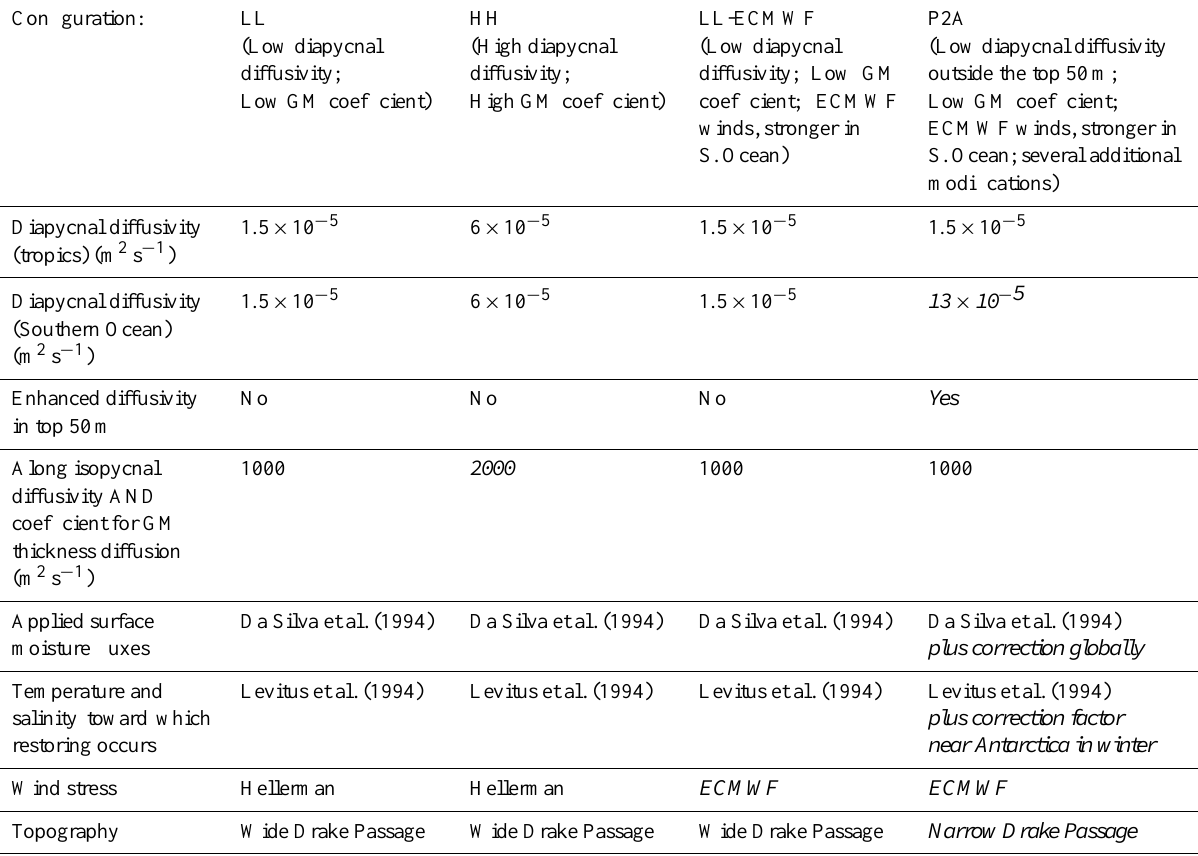
Table 1. Description of the four ocean GCMs. Model acronyms are described in the text. Differences from LL are highlighted in